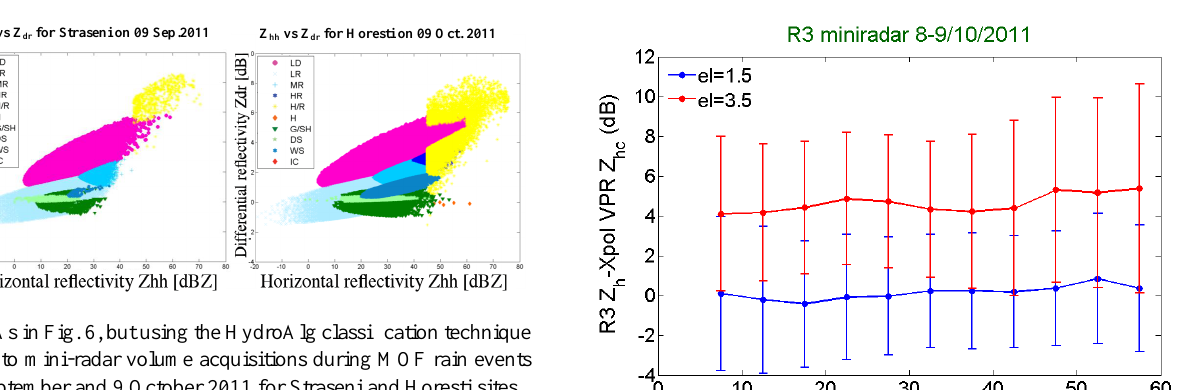
Figure 8. Example of VPR correction of XPol PPI scan at an antenna elevation of 3.0 o during 1 Figure 6. Scatterplot between Z hh and Z dr derived from numerical simulations at X band. The the rain event on 9/10/2011, showing the bright band due to the melting layer. scatterplot is segmented as a function of hydrometeor classes that are colour-coded. Z hh vs Z dr for Straseni on 09 Sep.2011 Z hh vs Z dr for Horesti on 09 Oct. 2011